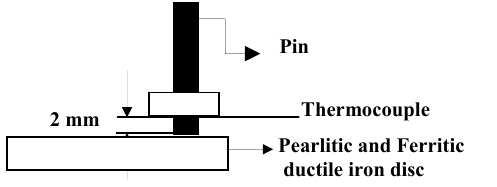
Figure 2. The position of the thermocouple in the brass